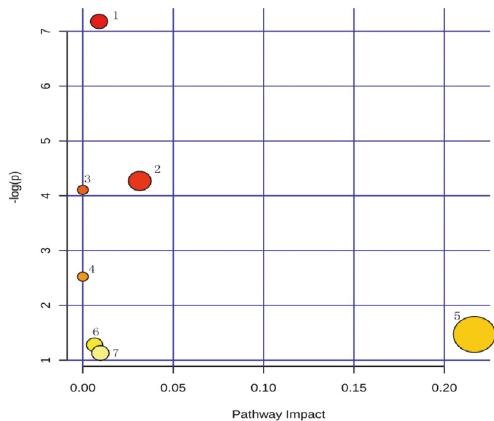
Figure 7: Differential metabolite related pathway in treatment of chronic liver failure with nonbioartificial liver. Note that numbers 1-7 represent different metabolic pathways, the name of metabolic pathways, and distribution parameters as shown in Table